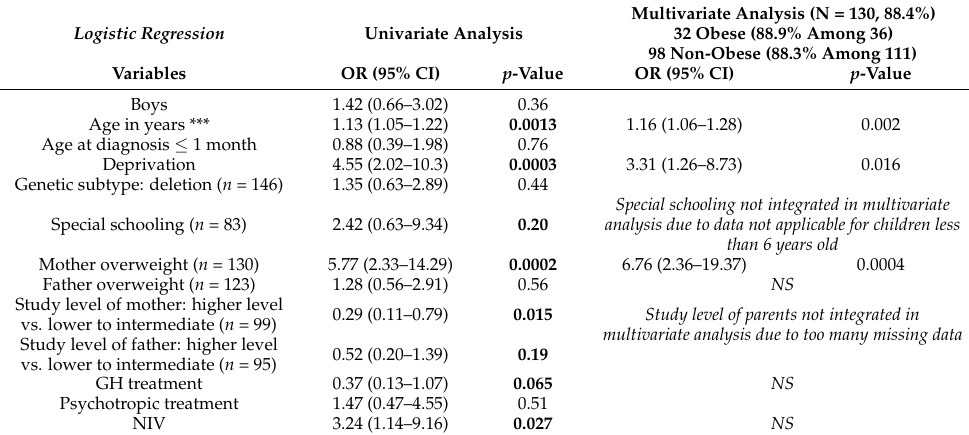
Table 3. Results of multivariable logistic regression analysis of obesity in children with